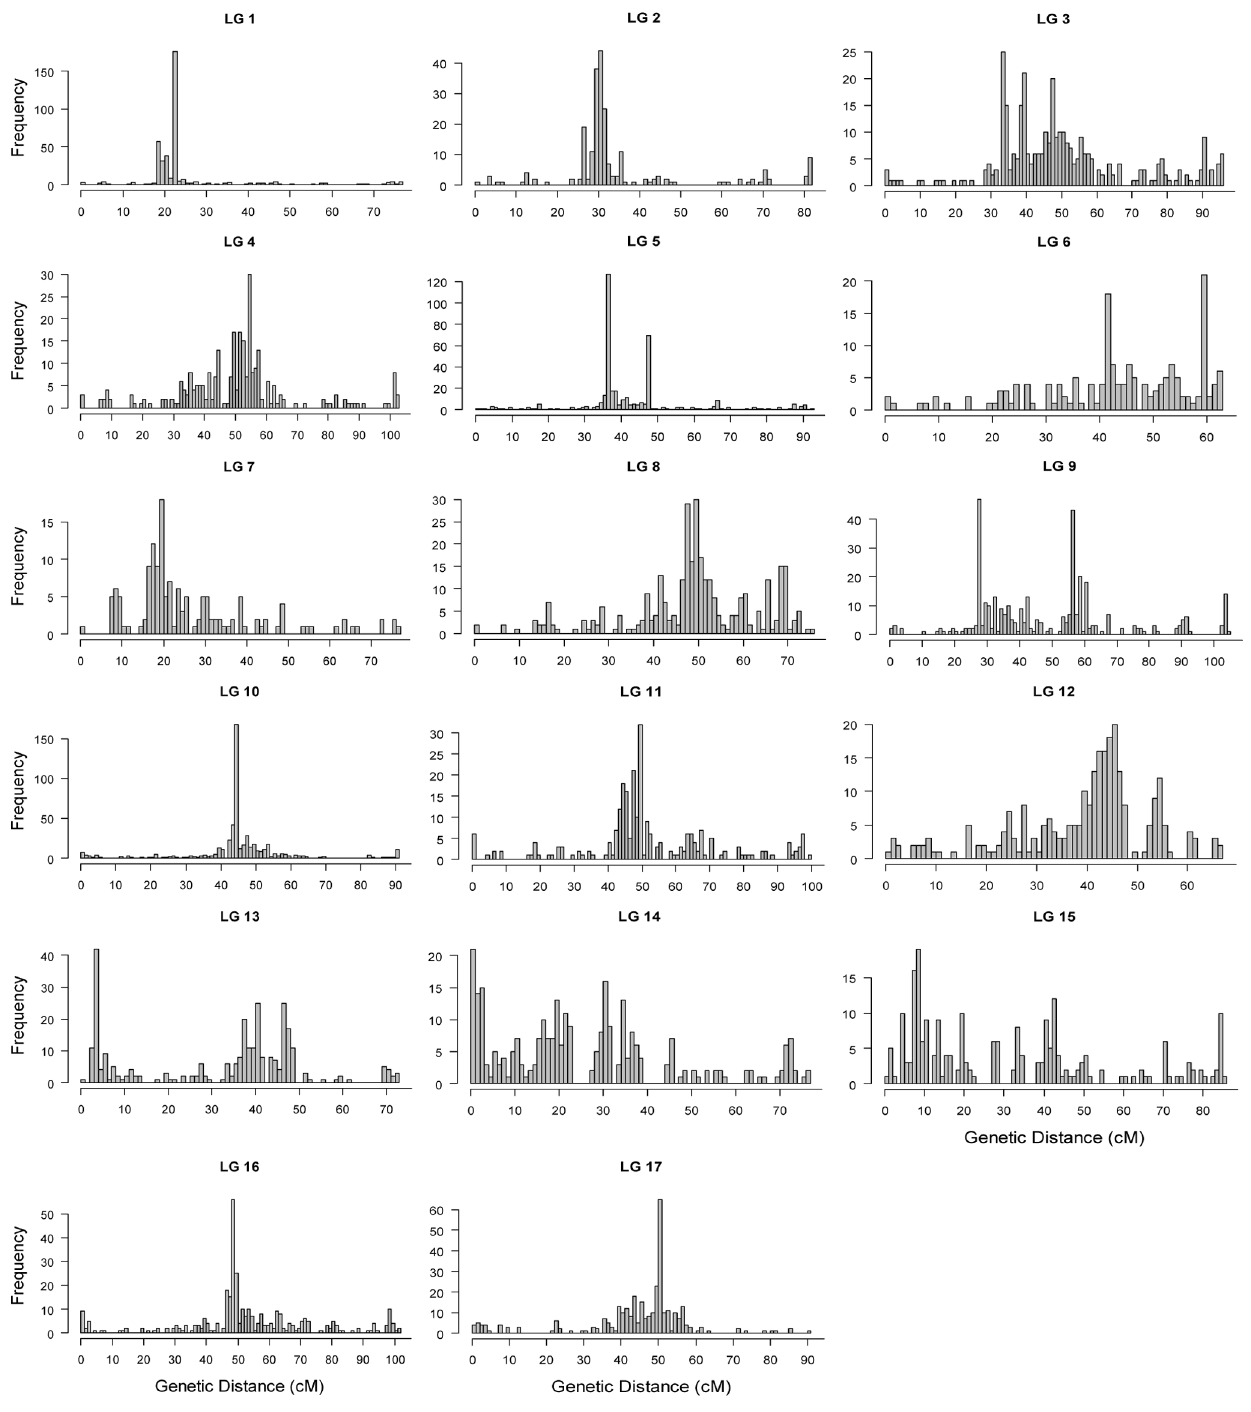
Figure 4. Frequency distribution of markers on the sunflower consensus map. A x-axis indicates genetic distance in each linkage group in 1-cM intervals and the y-axis indicates number of markers in each 1-cM bin.